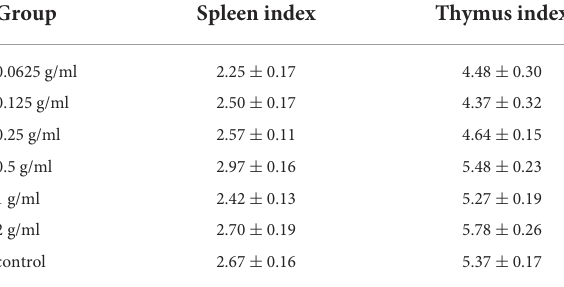
TABLE 3 Effect of DBD on the organ index in mice ( n = 10). Group Spleen index Thymus